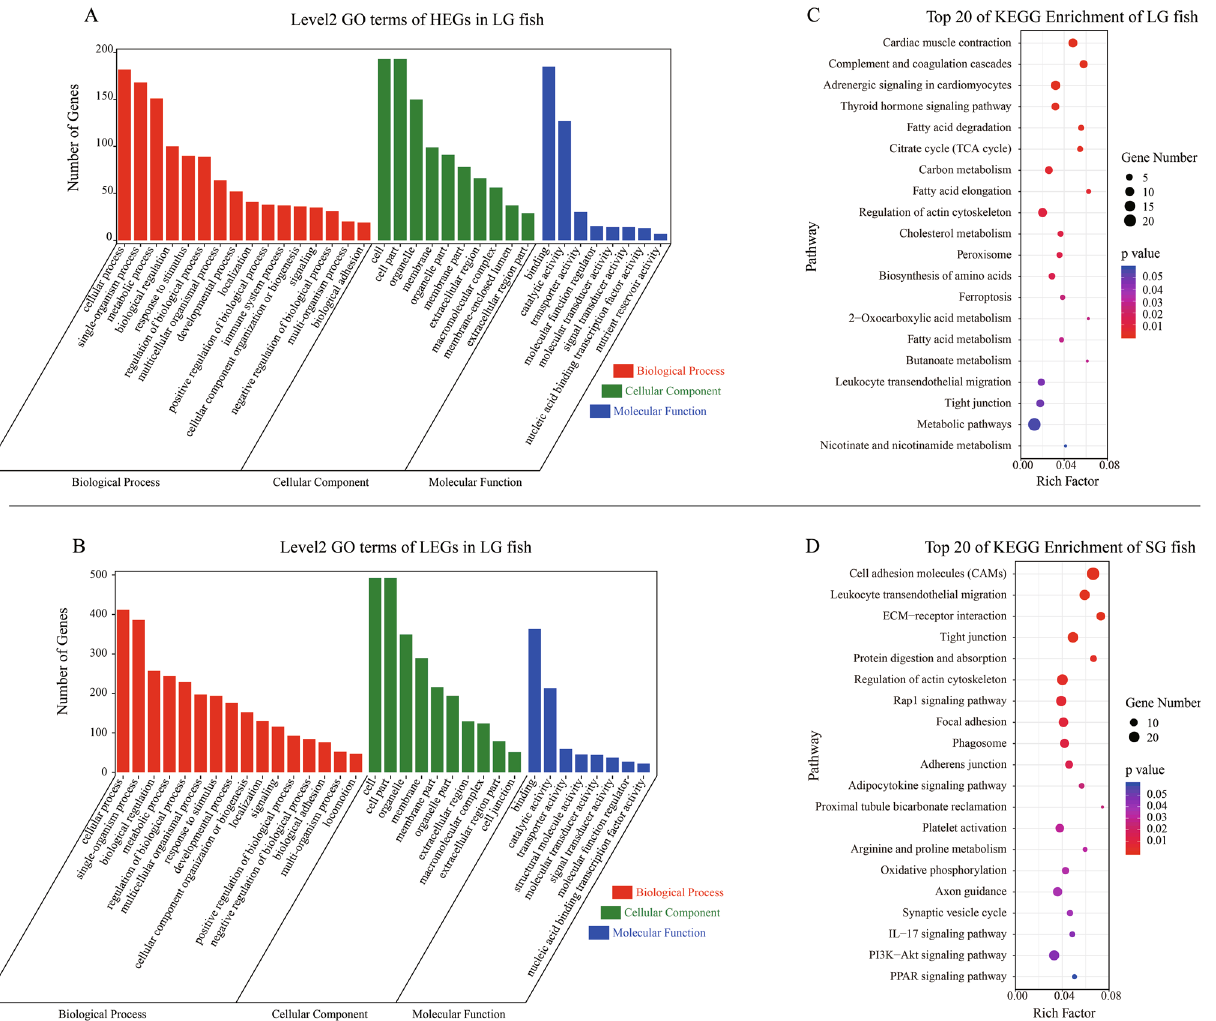
Figure 5. The GO annotation and KEGG pathways enrichment with HEGs of LG or SG loach. Note The HEGs in both groups include all the HEGs in the three tissues (brain, liver, and